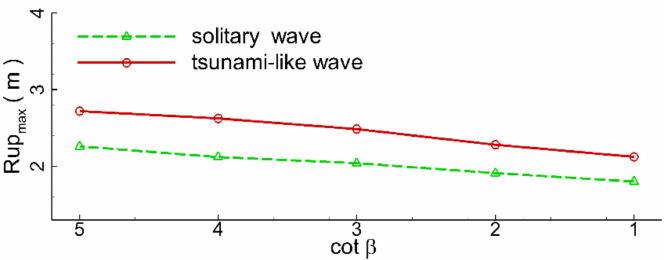
Figure 27. Variations in the maximum wave runup height with the side slopes of the